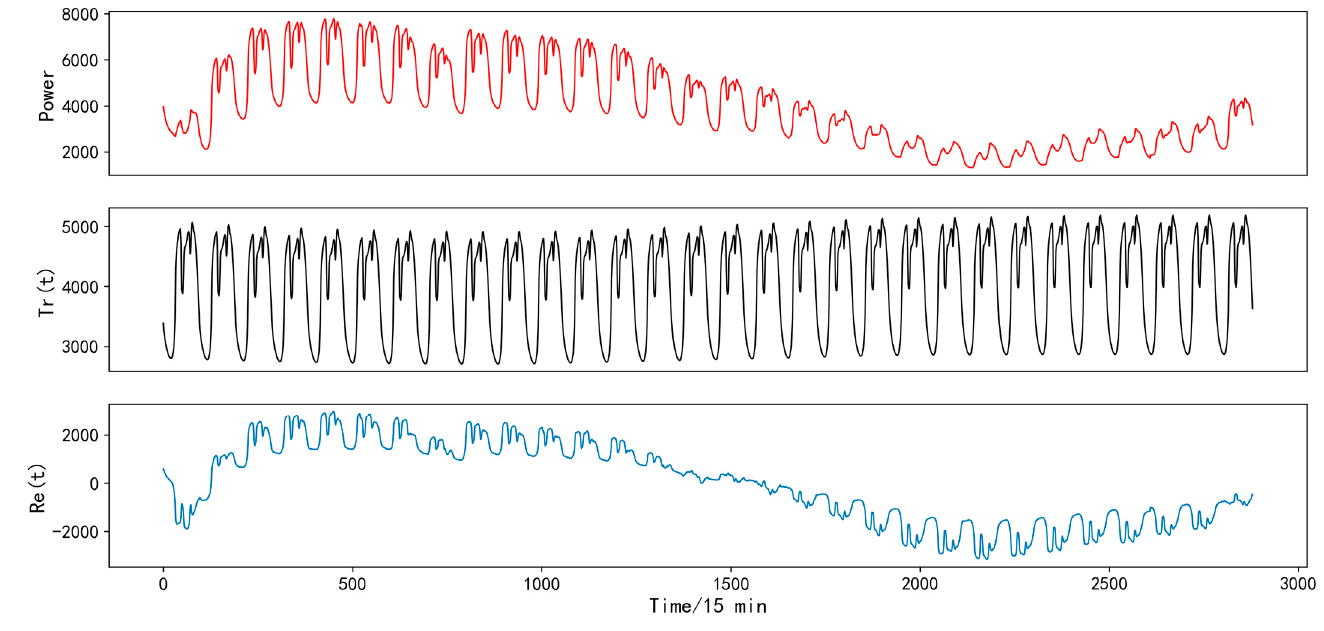
Figure 10. Area 1 EPT decomposition results.